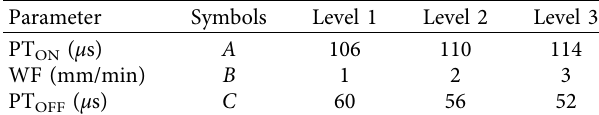
Table 3: Controllable process parameters and their limits.